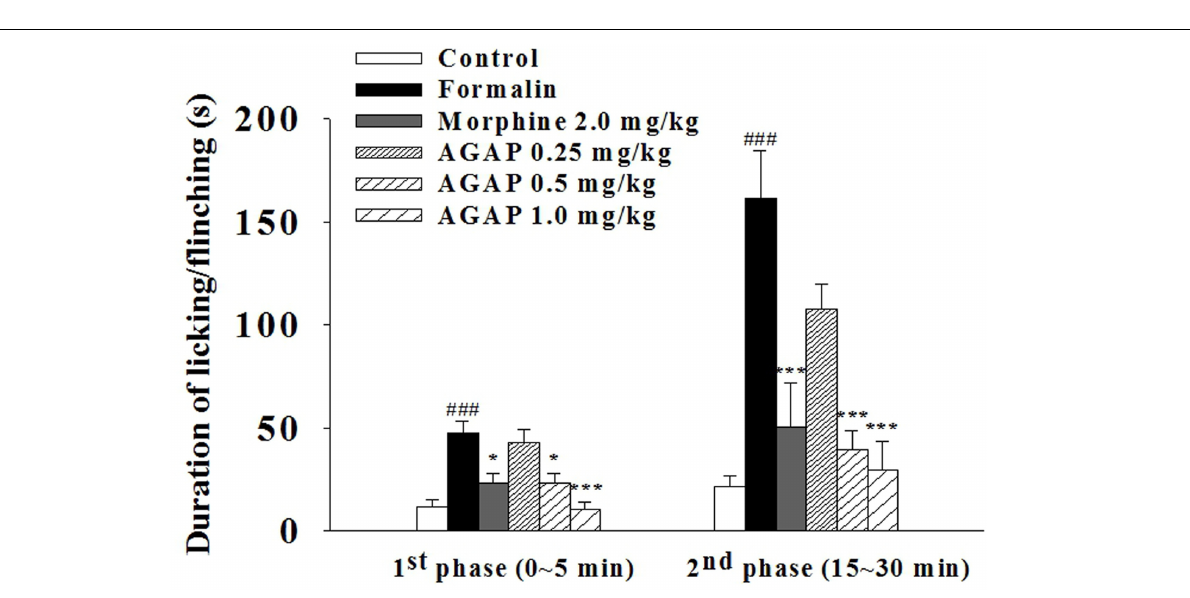
FIGURE 3 | Effect of AGAP against formalin induced licking and flinching in mice. AGAP at concentrations ranging from 0.25 to 1.0 mg/kg was administered intravenously 20 min before formalin injection. Morphine was administered at a dose of 2 mg/kg i.p. 30 min before formalin injection. The total time spent on licking and flinching of the affected paw was measured in the first (0–5 min) phase and the second (15–30 min) phase after intraplantar injection of formalin. AGAP dose-dependently attenuated the formalin-induced licking and flinching responses in both two phases. ### p < 0.001 compared with control group; ∗ p < 0.05, ∗∗∗ p < 0.001 compared with formalin group. Data are shown as the mean ± SEM ( n = 12 per group). P values are from two-way ANOVA followed by Bonferroni